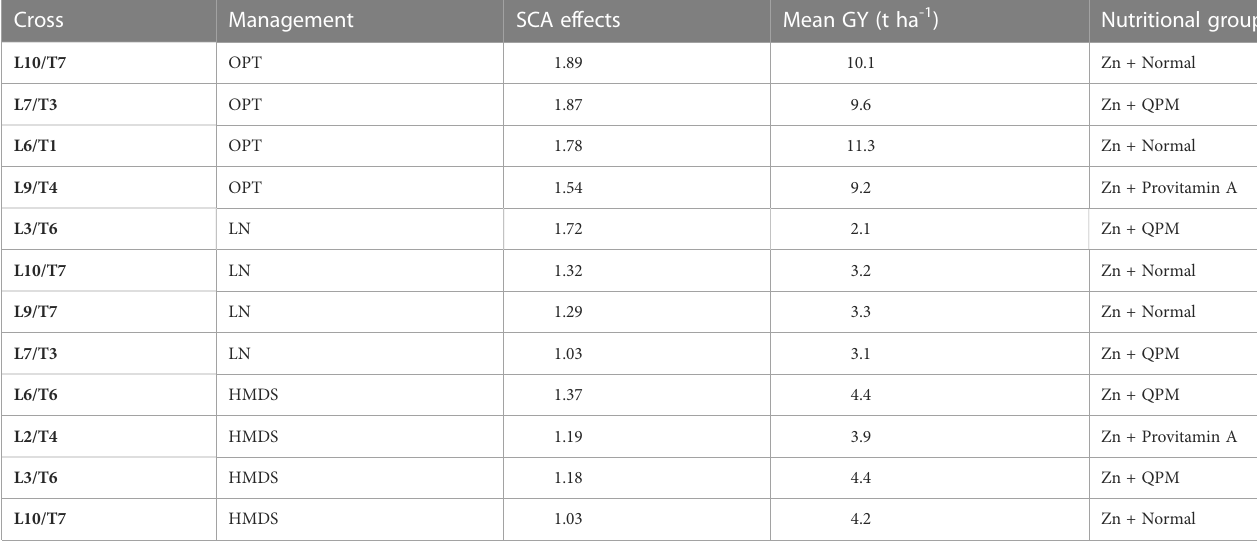
TABLE 9 Cross combinations with the highest SCA effects for grain yield under optimum, managed low N and heat and drought stress conditions.